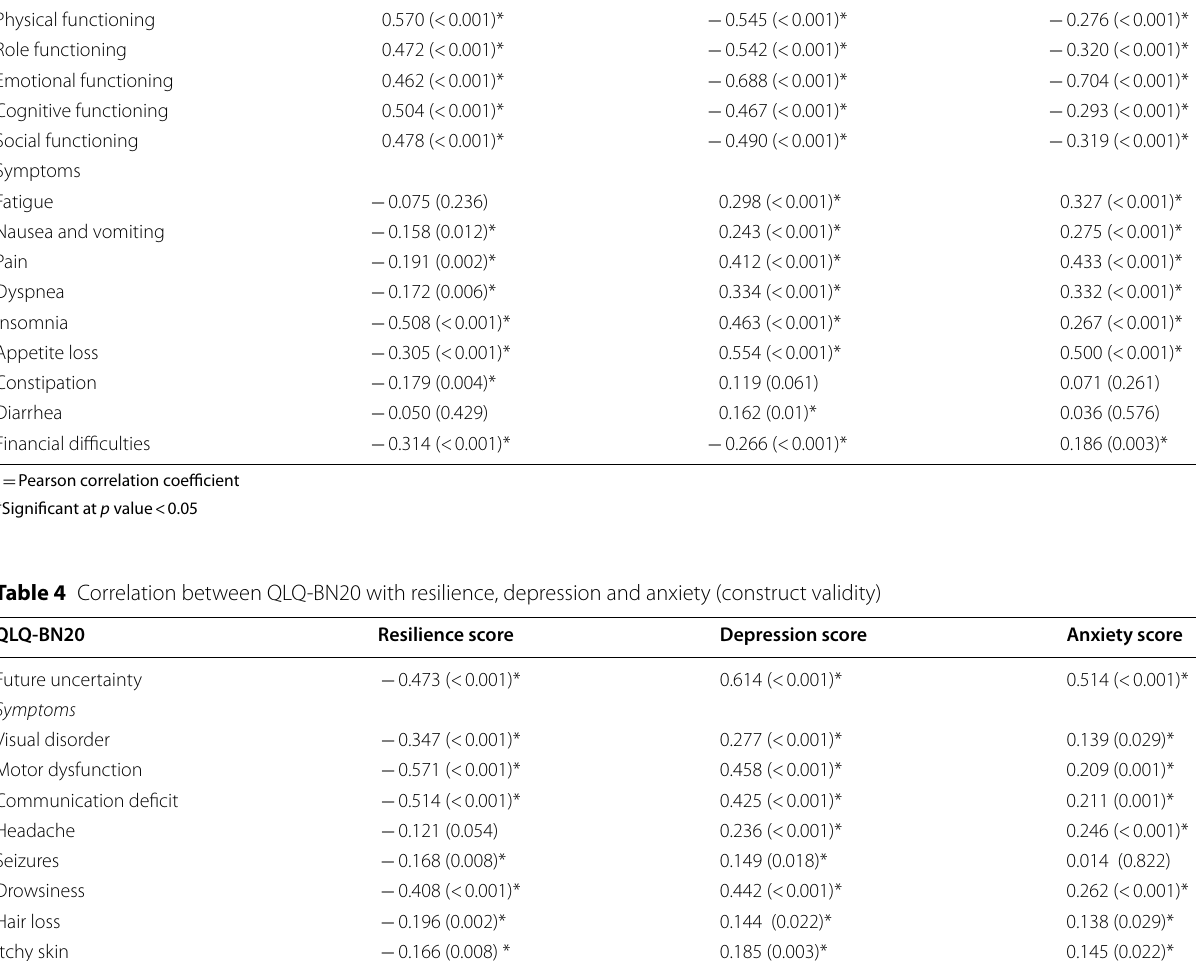
r Pearson correlation coefficient = *Significant at p value <